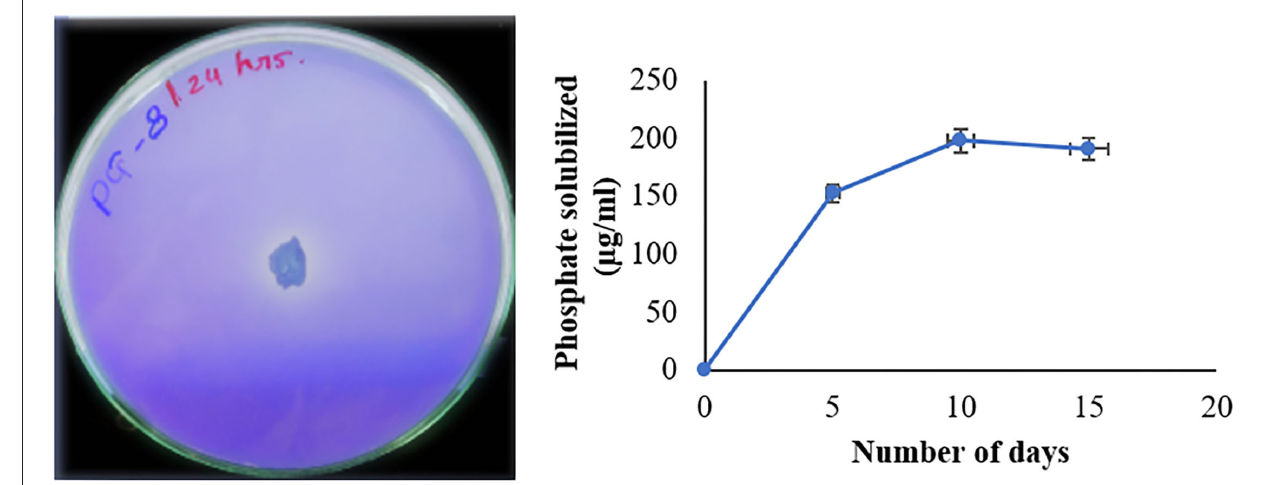
FIGURE 4 | Zone of phosphate solubilization on a plate and its rate in Pikovskaya’s broth.